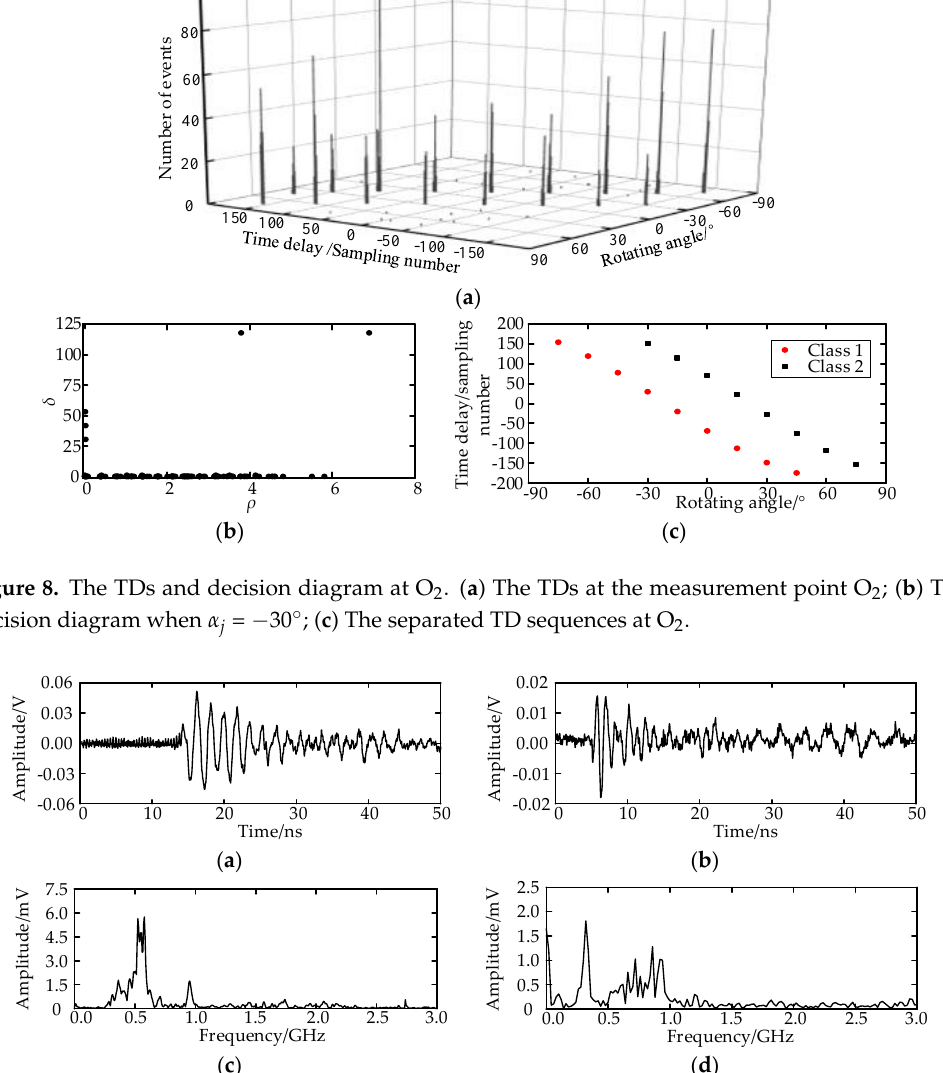
Figure 9. The UHF signals received at O 2 ; ( a ) The waveform of the UHF signal radiated from the first PD source; ( b ) The waveform of the UHF signal radiated from the second PD source; ( c ) The spectrum of the UHF signal radiated from the first PD source; ( d ) The spectrum of the UHF signal radiated from the second PD source.